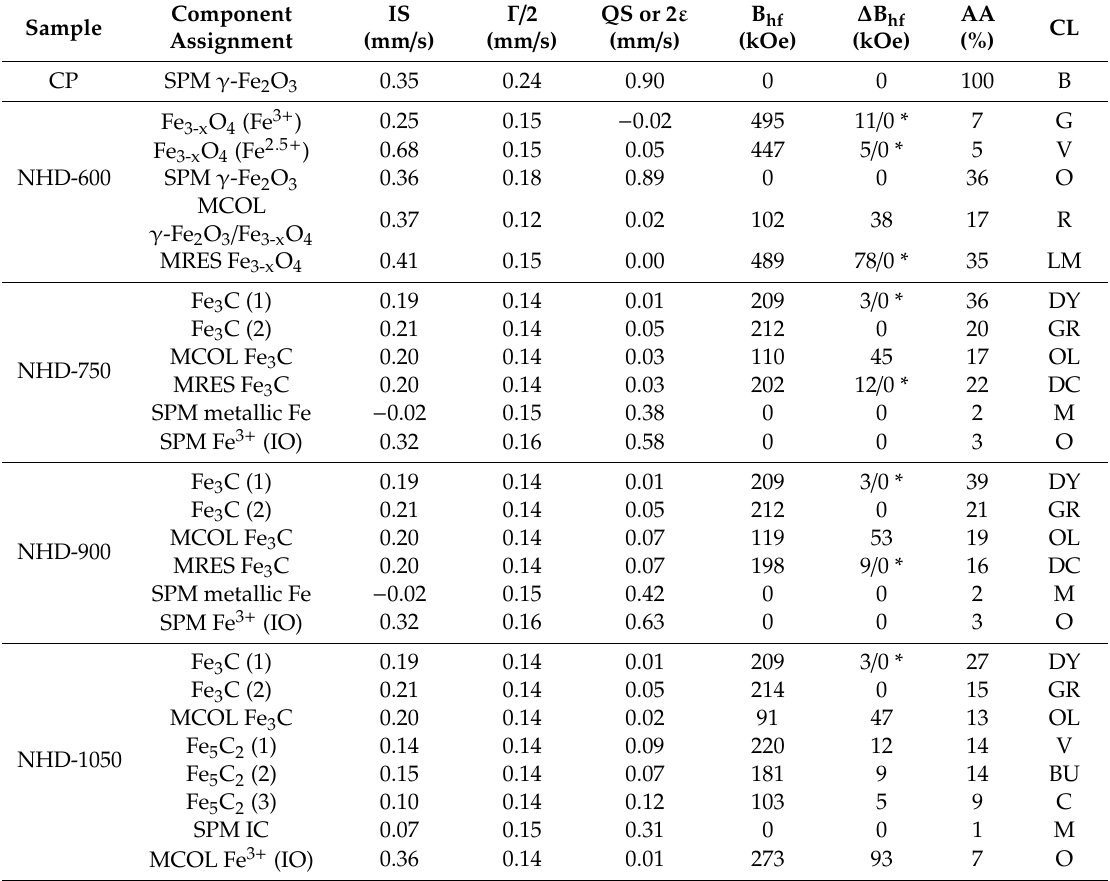
Table 3. Mössbauer hyperfine parameters resulting from the best fits of the corresponding spectra of the samples recorded at 300 K. IS is the isomer shift (given relative to α -Fe at 300 K), Γ / 2 is the half line-width, QS is the quadrupole splitting, 2 ε is the quadrupole shift, B hf is the central value of the hyperfine magnetic field, ∆ B hf is the spreading of B hf , and AA is the relative spectral absorption area of each component used to fit the spectra. Typical errors are ± 0.02 mm / s for IS, Γ / 2, 2 ε and QS, ± 3 kOe for B hf and ± 5% for AA. * denotes the cases where asymmetric ∆ B hf spreading was allowed for lower / higher values relative to B hf . Component colors (CL): B = black, BU = blue, C = cyan, DC = dark cyan, DY = dark yellow, G = gray, GR = green, LM = light magenta, M = magenta, O = orange, OL = olive, R = red, V =